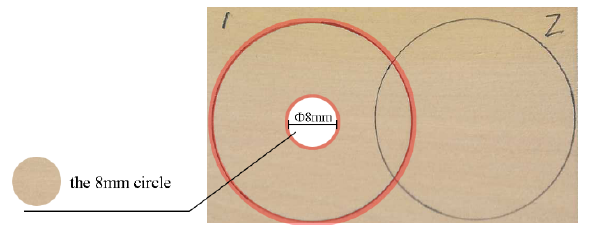
Figure 2. Acquisition of the calculated area.